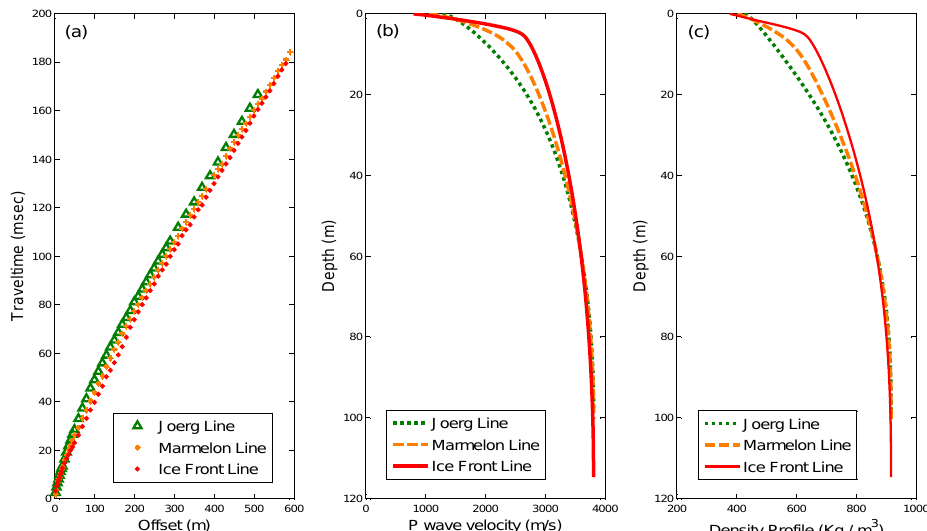
Fig. 4. (a) Traveltime against offset for the 3 seismic refraction experiments indicating a monotonic velocity increase with depth, inferred from the continuous increase in traveltime with offset; (b) seismic velocity-depth profiles derived using the method of Kirchner and Bentley (1990) for the three seismic refraction profiles. Velocities at depths beyond 100m are constrained by temperature profiles discussed by Nicholls et al. (2012) and the velocity-temperature relationship of Kohnen (1974); (c) density-depth profiles derived using the method of Kohnen